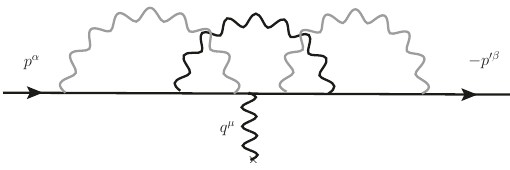
Figure 3 . Single fermion line contributions to the QED g − 2